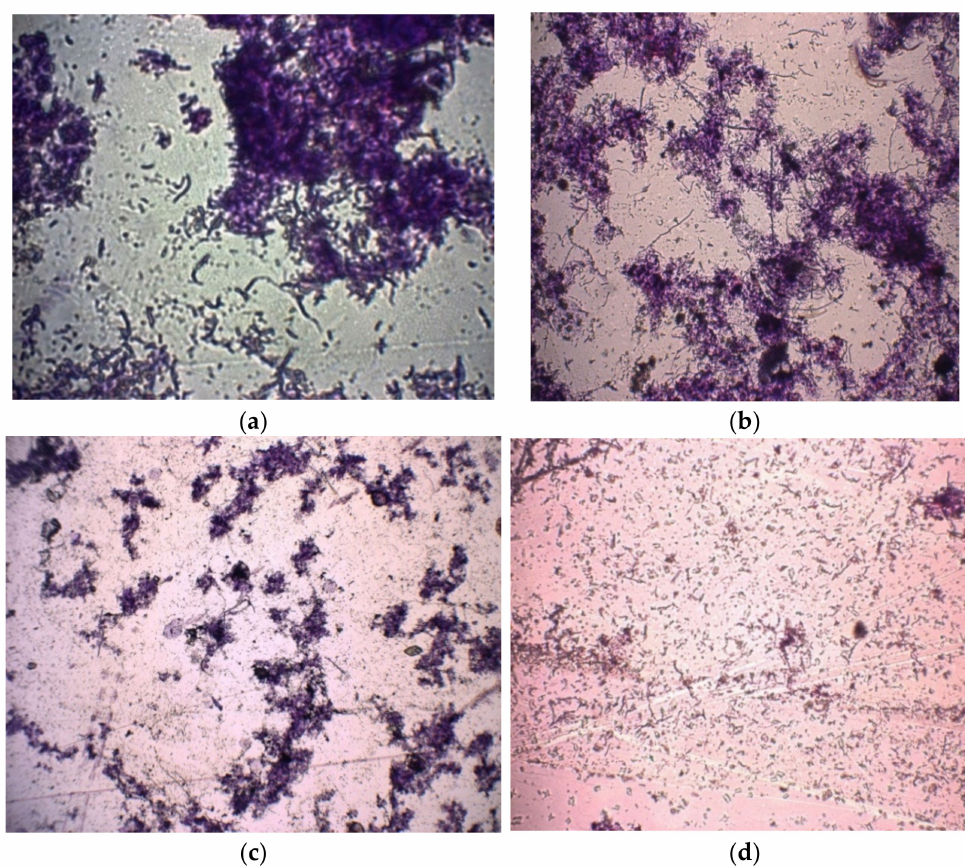
Figure 6. Deflocculation of activated sludge flakes when adding a sludge mixture with non-ionic surfactant at different concentrations, per gram, magnification × 40: ( a )—control; ( b )—surfactant = 10 mg/dm 3 ; ( c )—surfactant = 30 mg/dm 3 ; ( d )—surfactant = 50 mg/dm 3